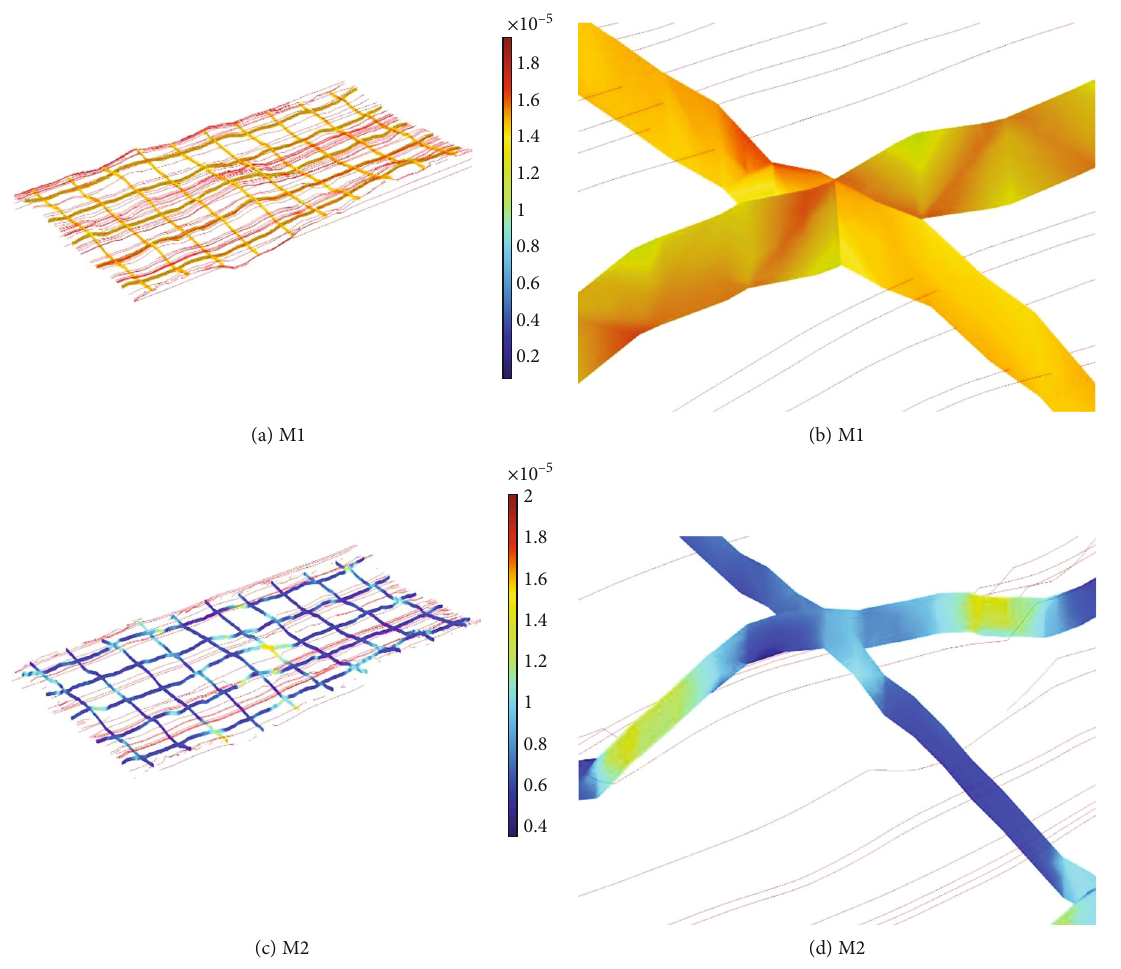
Figure 13: Fluid fl owing through fractures in the steady